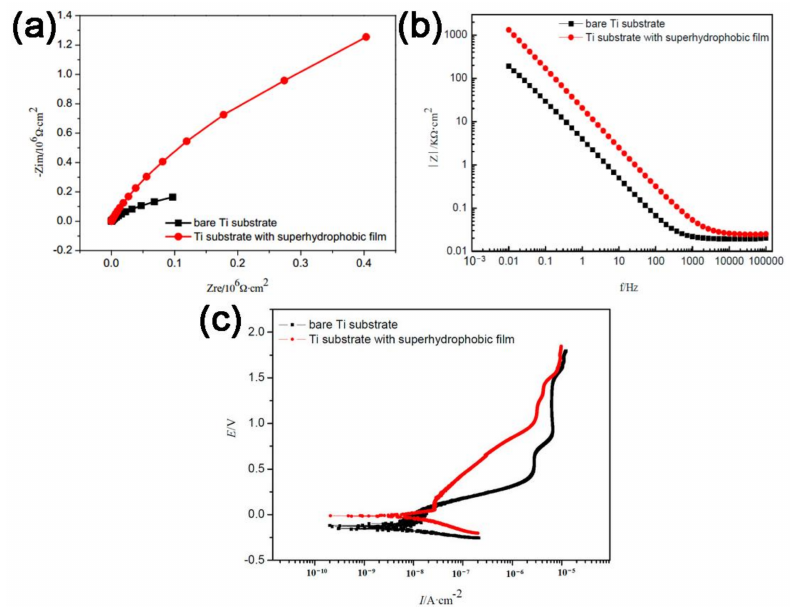
Figure 6. ( a , b ) Nyquist and Bode plots for the super-hydrophobic Ti surface and bare Ti substrate, respectively; ( c ) Polarization curves of super-hydrophobic Ti surface and bare Ti substrate. Reprinted from [70]. Copyright (2017), with permission from MDPI